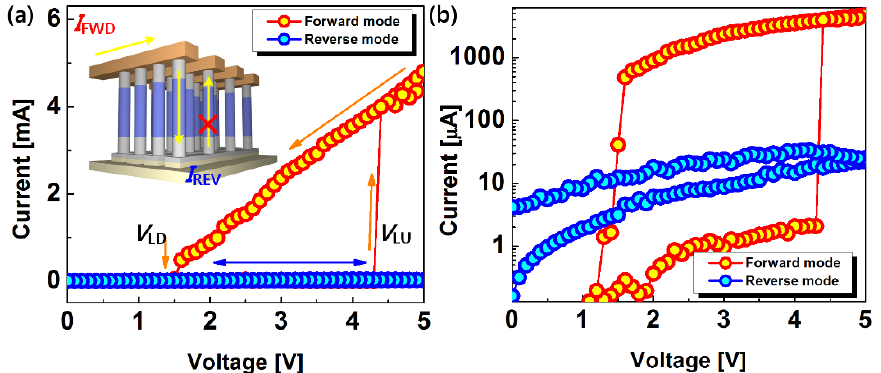
Figure 3. Hysteresis of the I-V characteristics (( a ) linear scale, ( b ) semi-log scale) of the fabricated vertical Ge biristor for different reading directions (forward mode: collector side and reverse mode: emitter side). The bi-stable state is only observed for the forward mode. The counterclockwise loop has a V LU of 4.3 V and V LD of 1.5 V.